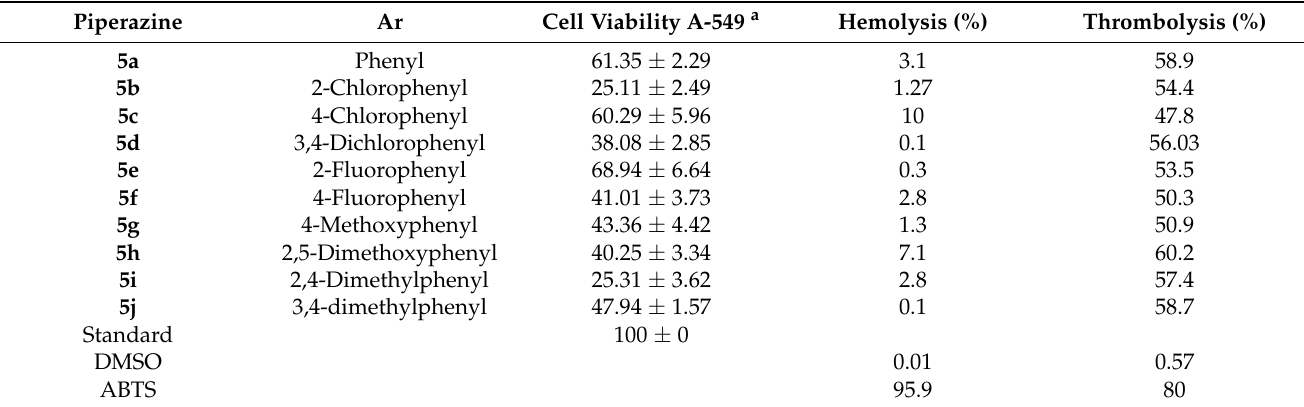
Table 1. The anti-lung cancer activity, hemolytic, and thrombolytic potential of piperazine-1- carbodithioates 5a – 5j according to Scheme